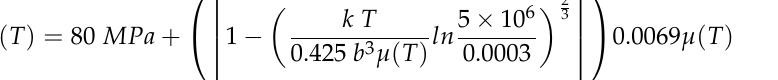
Table 2. The final form of Equation (4) giving the yield strength as a function of